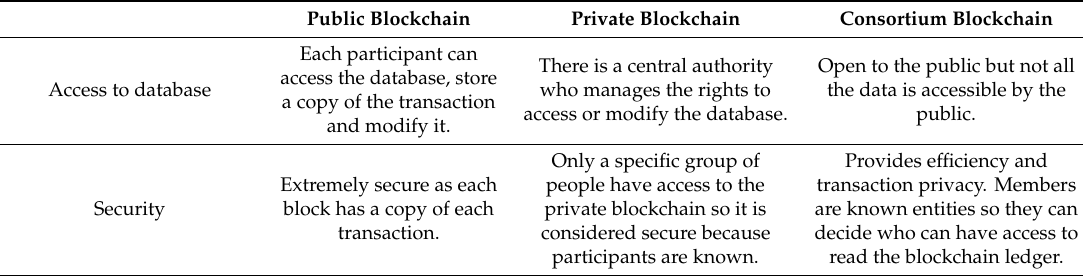
Table 1. A summary of blockchain types and their characteristics [7].